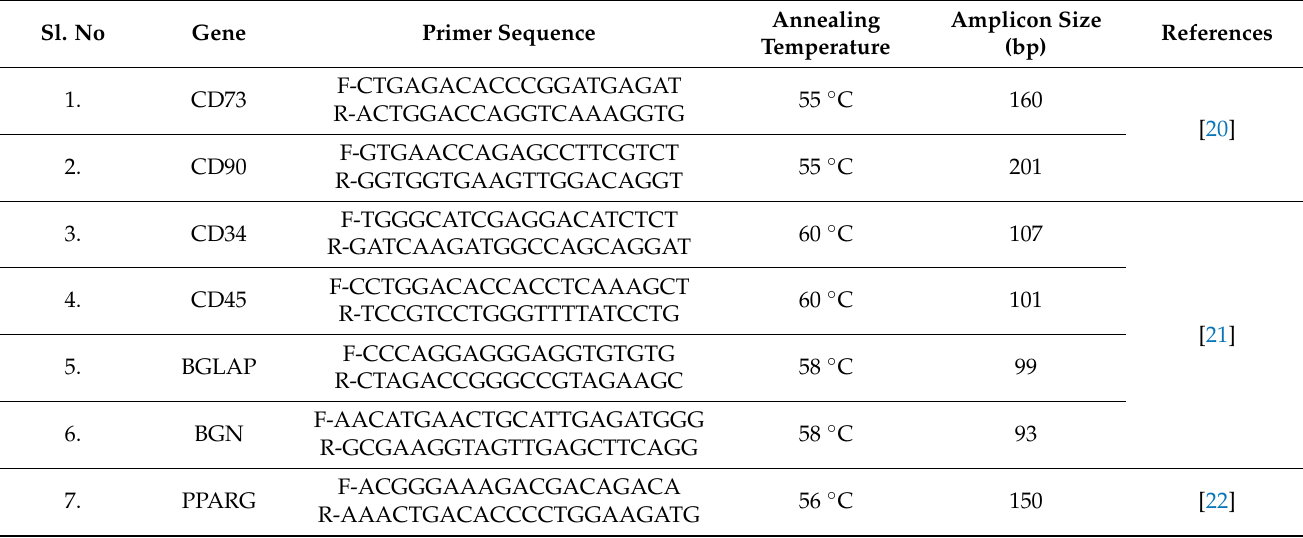
Table 1. Primer sequences of phenotypic markers (F: Forward and R: Reverse) and the length of the amplicon in base pairs